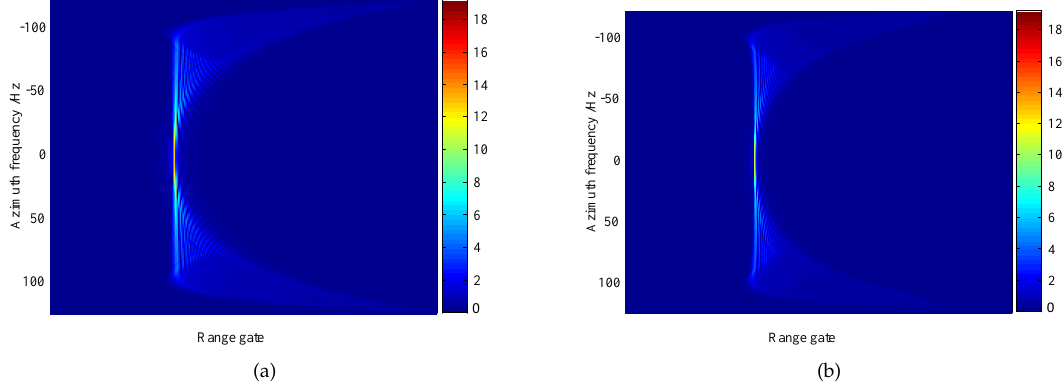
Figure 2. Range migrations of point target at a range of 12 km after RCMC. ( a ) Algorithm in Reference [26] (6th order model). ( b ) Algorithm in Reference [26] (7th order